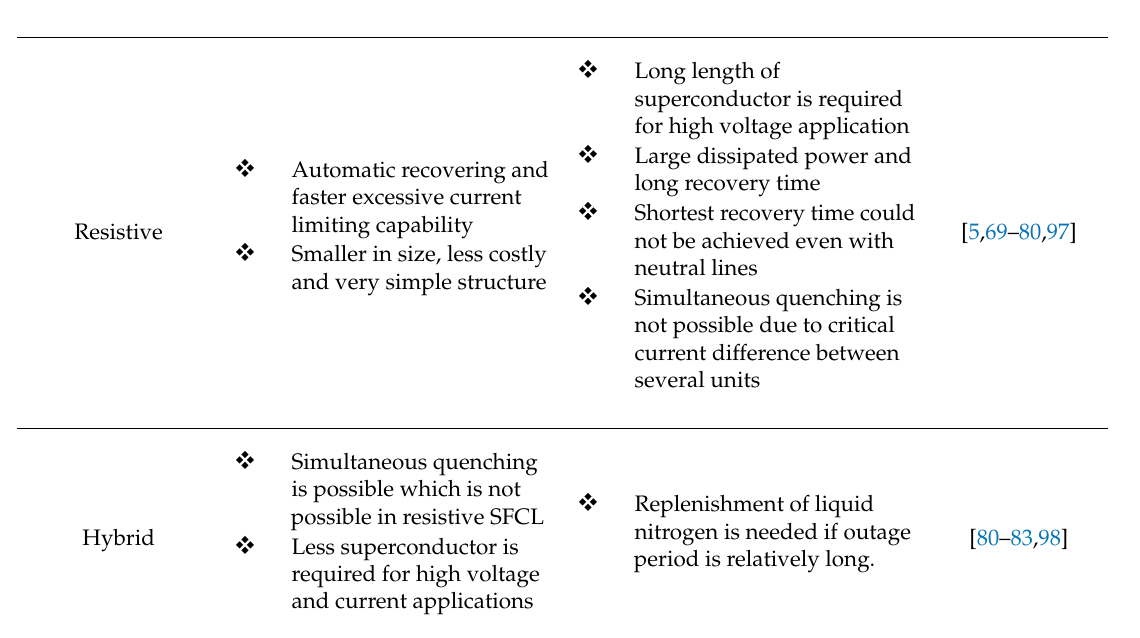
Figure 4. The phases for implementing a N-AHP in SWOT analysis.